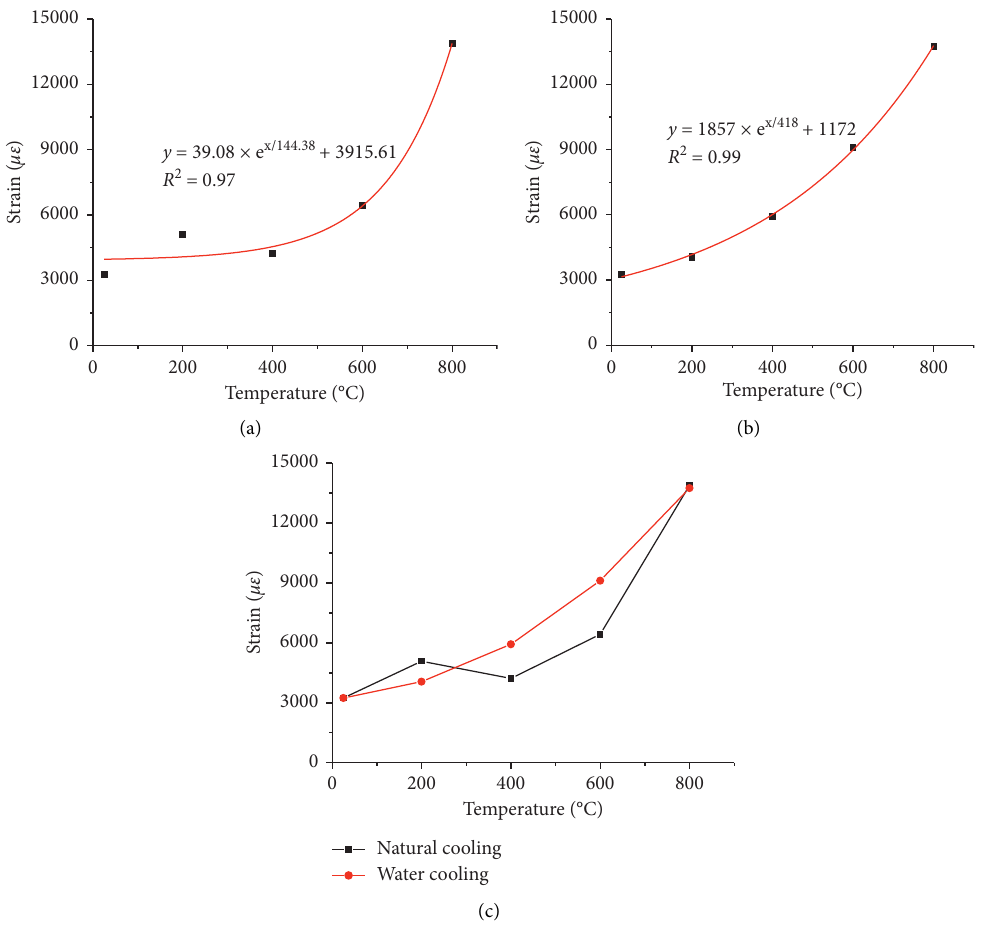
Figure 10: Relationship between strain and temperature (natural cooling and water cooling). (a) Natural cooling; (b) water cooling; (c) effect of cooling mode on peak strain of Skarn.